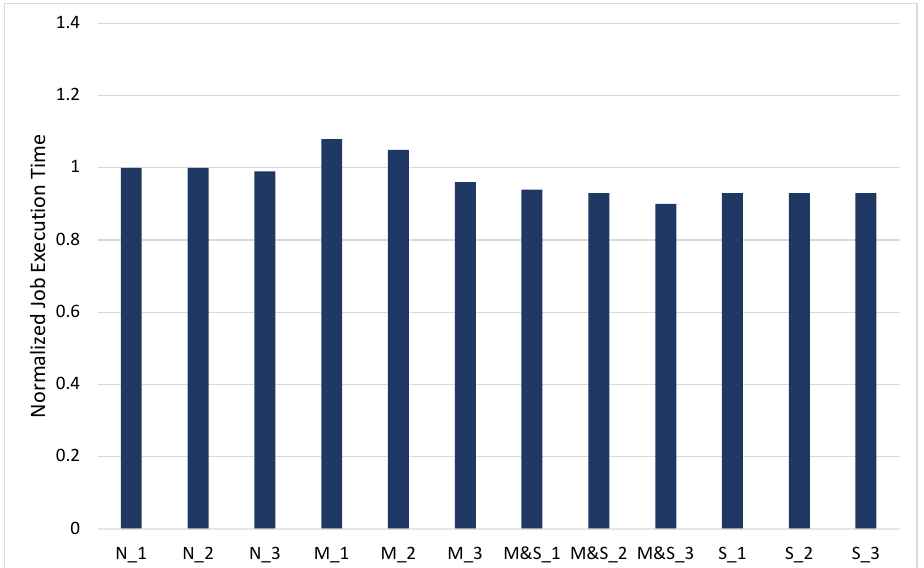
Figure 9. The normalized k-means clustering job execution time for 1.5 GB